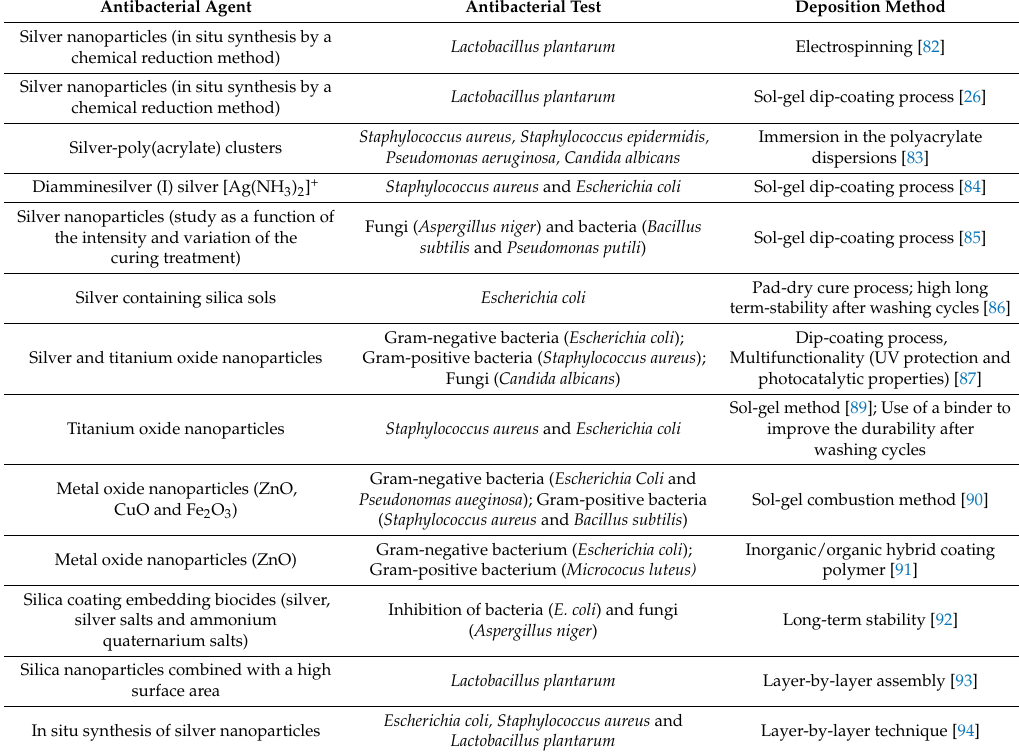
Table 3. Summary of the antibacterial agents as well as deposition method evaluated in this work against a specific type of